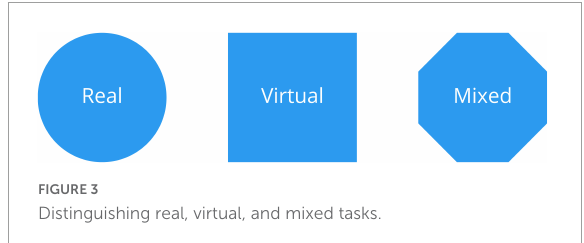
FIGURE3 Distinguishing real, virtual, and mixed tasks.